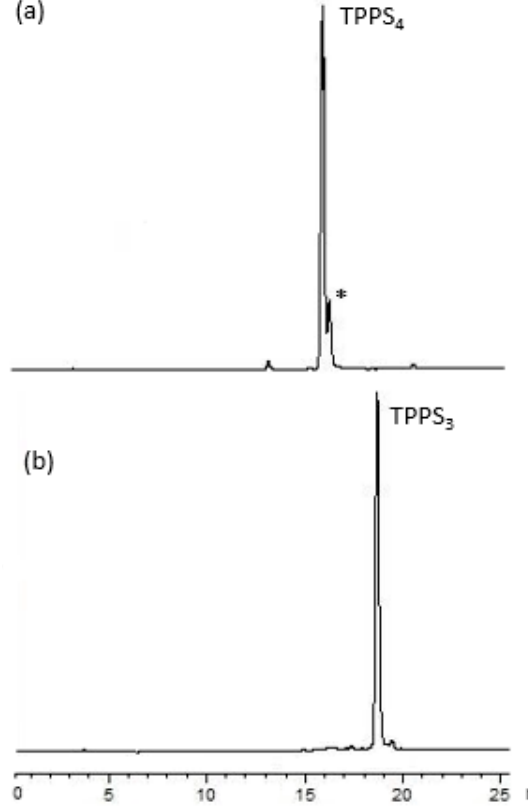
Figure 2. Reverse-phase HPLC analysis of TPPS 4 ( a ) and TPPS 3 ( 1 ) ( b ) samples. The impurity (*) in ( a ) corresponds to the regioisomer with one of the sulfonate groups in the meta position; the analogous impurity in the trisulfonated counterpart can be more easily separated in the desalting process to afford pure fractions of 1 . See the Materials and Methods Section for the detailed chromatographic conditions and procedures.